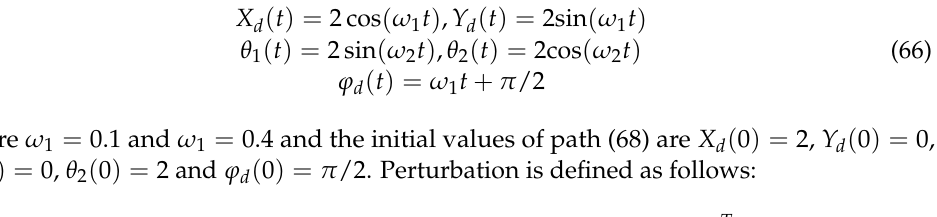
Table 1. Robot kinematic parameters [39–41]. Parameter Description Value (m) b The distance of wheel to the robot center line 0.180 d The distance of wheels axis and robot center of mass 0.115 r Wheel radius 0.05 L a The distance of point P to the robot center of mass 0.1 L 1 Link 1 length 0.15 L 2 Link 2 length 0.1 L cm 1 Location of the link 1 center of mass 0.075 L cm 2 Location of the link 2 center of mass